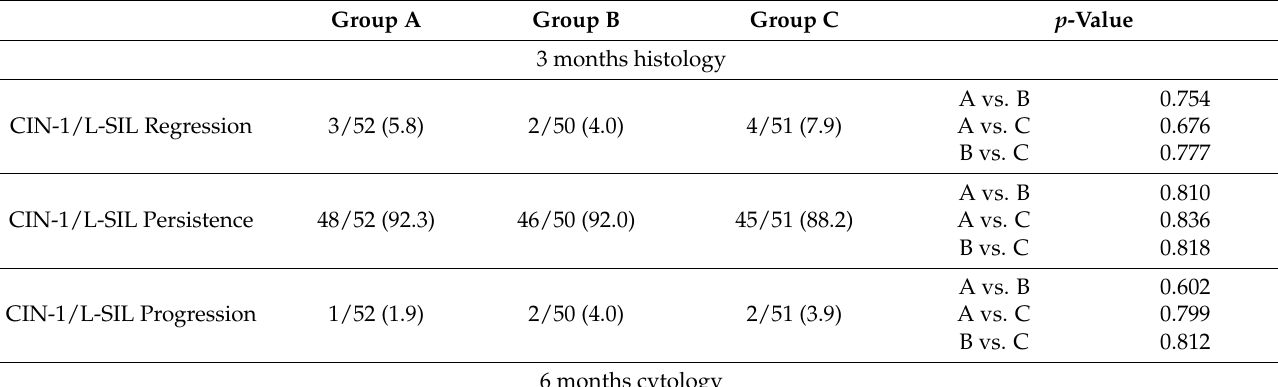
Table 2. Regression, persistence, and progression of CIN-1/L-SILs during the 12-month follow-up. Group